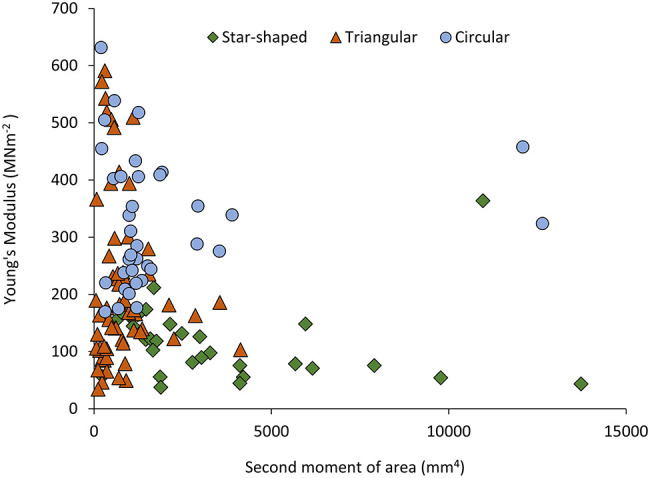
Young's Modulus (MNm−2) plotted against second moment of area (mm4) for the three stem types of Selenicereus setaceus (circular, triangular and star-shaped): highest values of stiffness are found in the circular stems, followed by intermediate values in the triangular and the lowest values in star-shaped searcher stems (ncirc = 36; ntri = 62; nstar = 34).